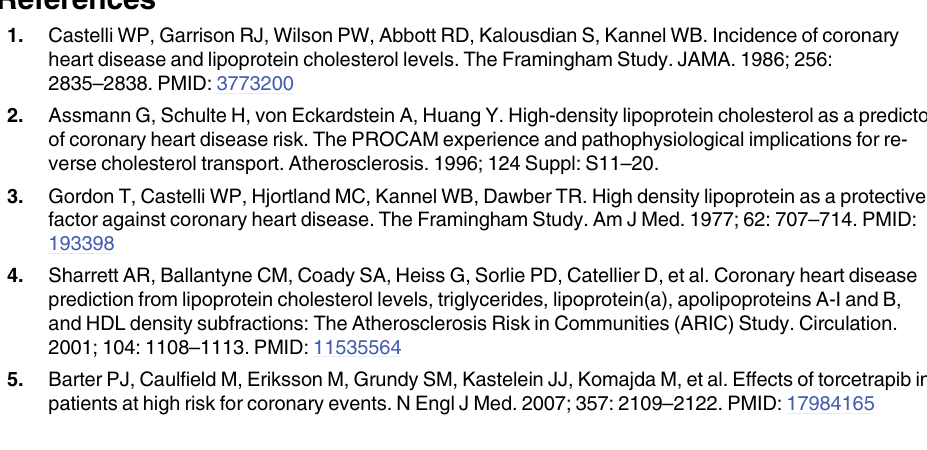
S1 Table. Dietary intake during the placebo and resveratrol period, as estimated with food- frequency questionnaires. S2 Table. Effect of 4-wk resveratrol intake on hematologic, hemostatic and general health